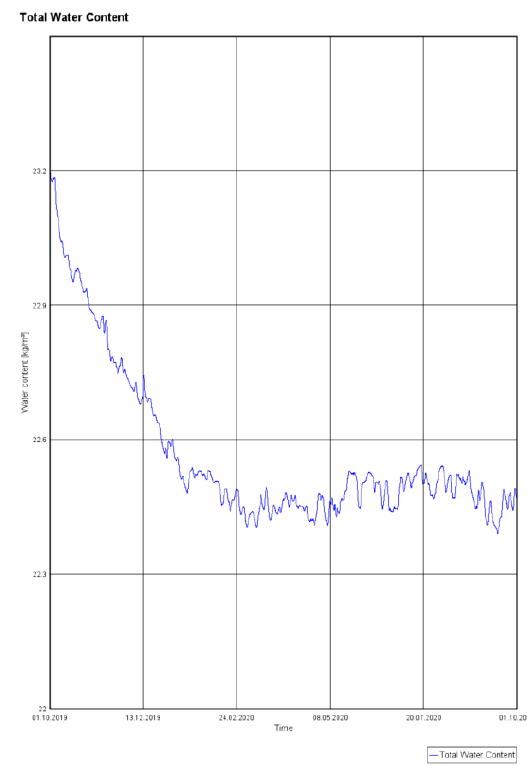
Figure 27. ( a ) Geometric model ( b ) Geometric model with a FEM (Finite Element Method) mesh (example for the alternative with internal insulation). The other materials as the same as in Figure 13.